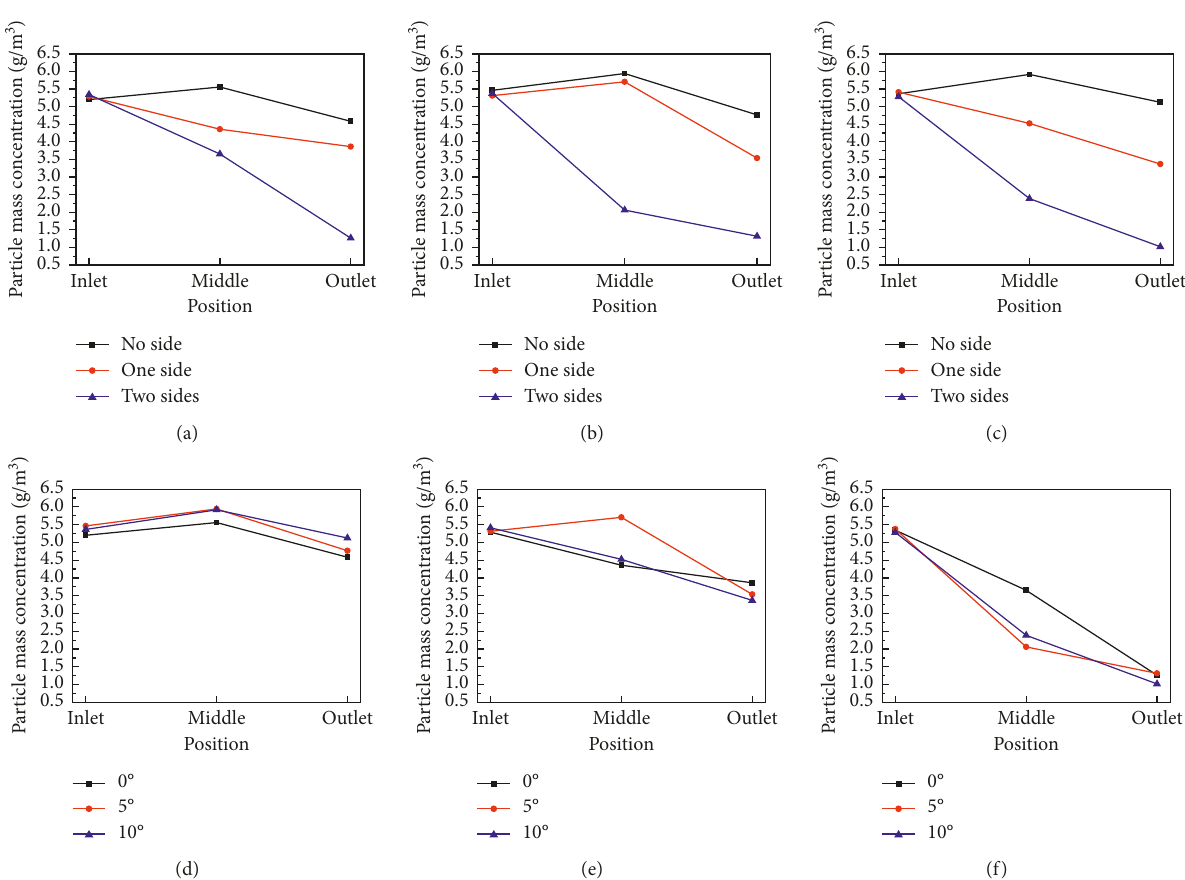
Figure 3: Simulation results of dedusting effect for the corrugated plate. (a) Angle is 0 ° . (b) Angle is 5 ° . (c) Angle is 10 ° . (d) No side trap for dust. (e) One side trap for dust. (f) Two sides trap for